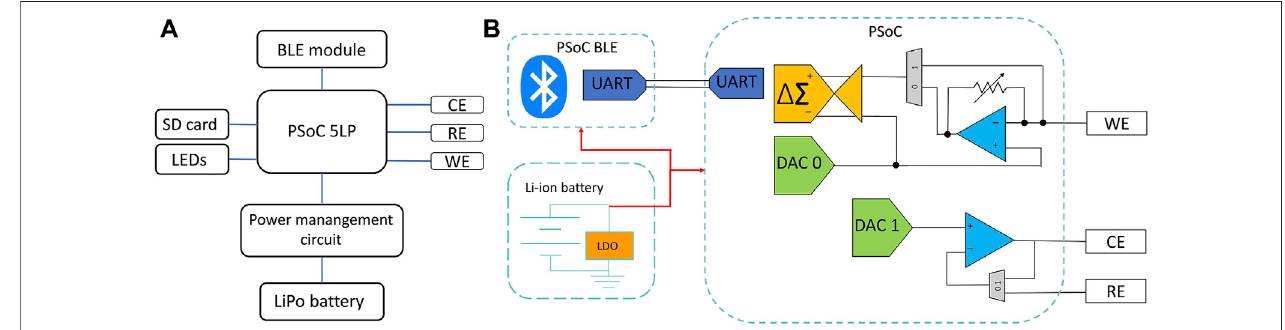
FIGURE 2 | (A) Block diagram of the device components. (B) Potentiostat circuitry implemented in KAUSTat.